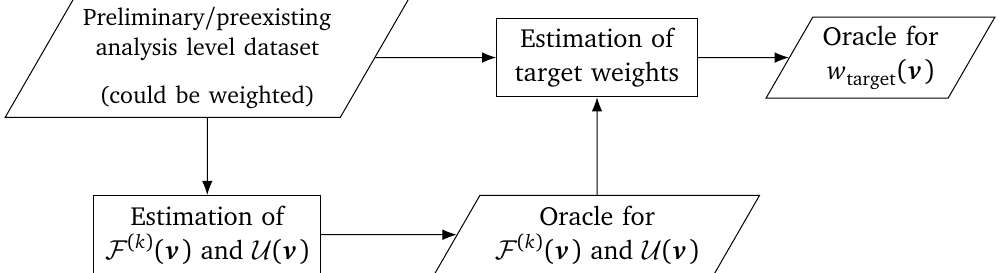
Figure 8: A flowchart of the main steps of the first stage of OASIS discussed in Sec- tion 3.2.1. Rectangles refer to processes or actions, while the remaining parallelo- grams refer to the corresponding inputs or deliverables. The estimation of ( v ) can be done using existing regression techniques. The techniques intro- and U duced in Section 2 can be used to perform the estimation of w